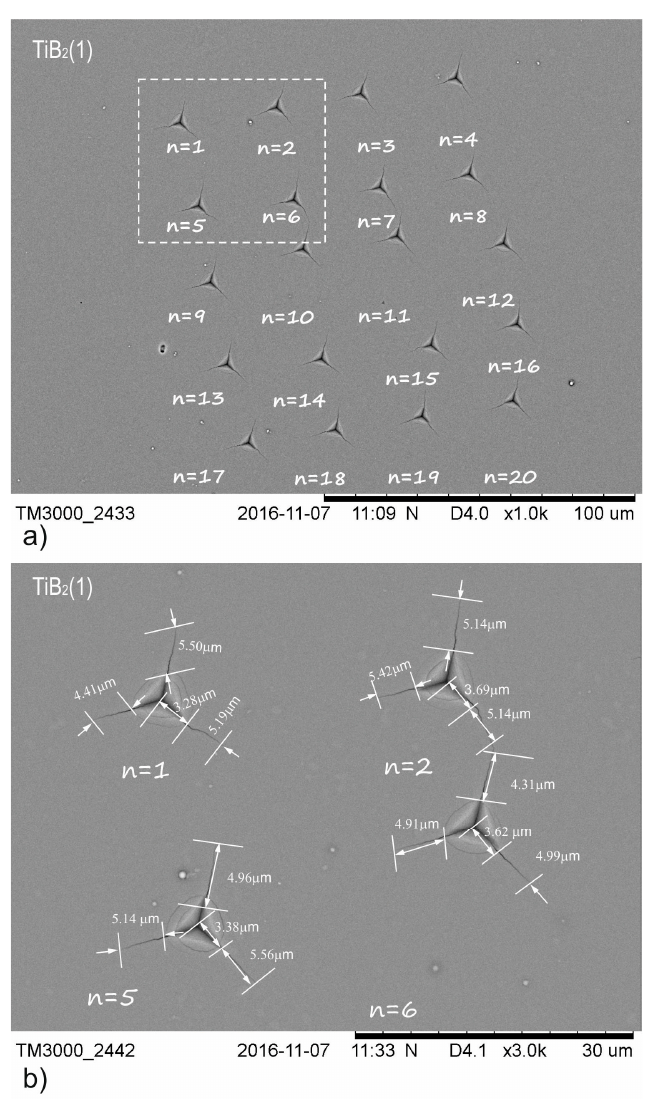
Figure 3. SEM images of groups indentations used for TiB 2 (1) of fracture toughness analysis: ( a ) series of 20 indentations at a load of P critical = 200 mN; ( b ) representation of crack lengths for different indentations where n = 1, 2, 5, 6.